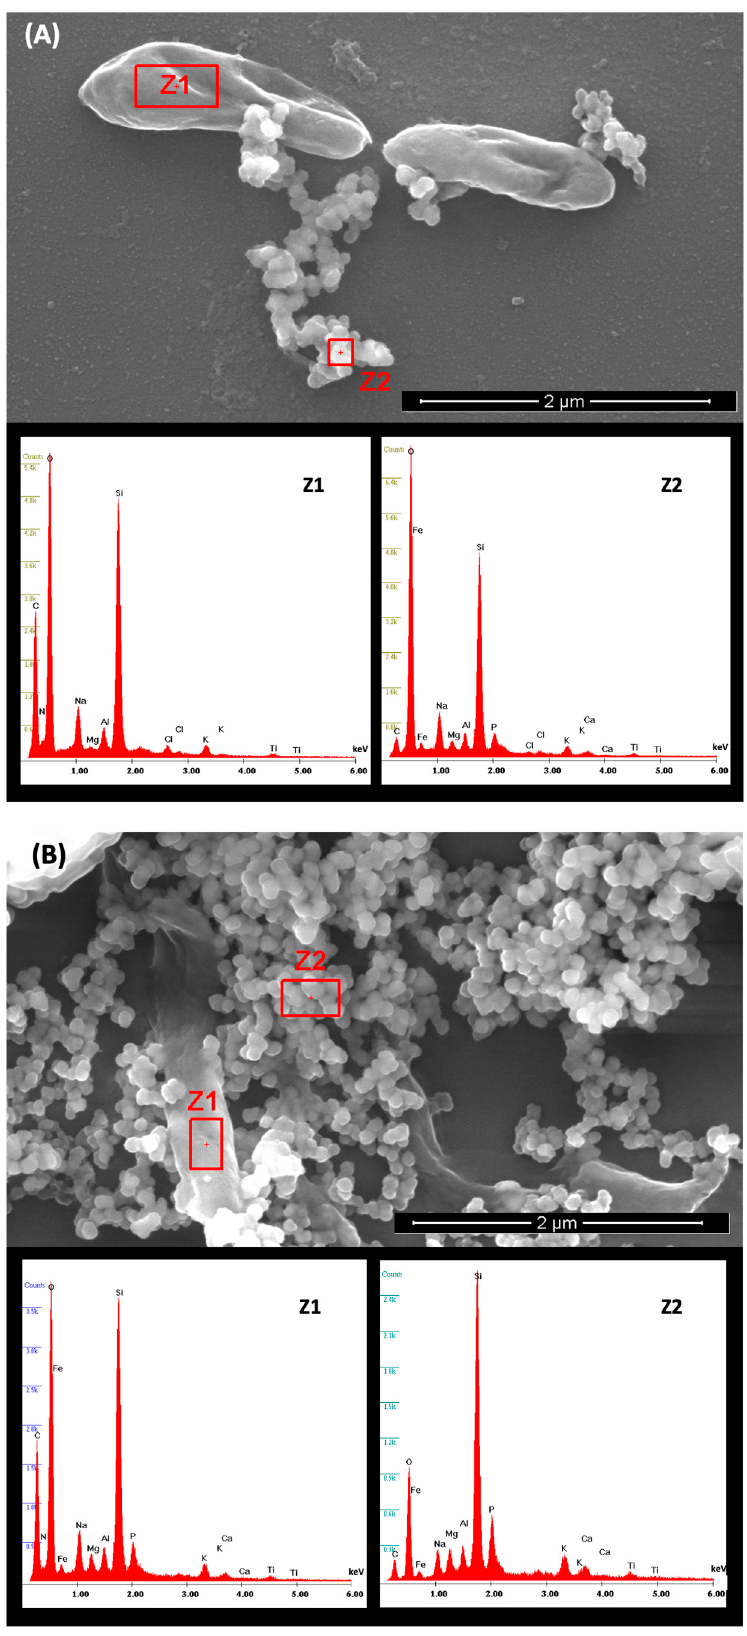
Figure 6. SEM image from microcosms: ( A ) magnetite, ( B ) hematite and EDS analysis corresponding to the areas Z1 and Z2 outlined in red.